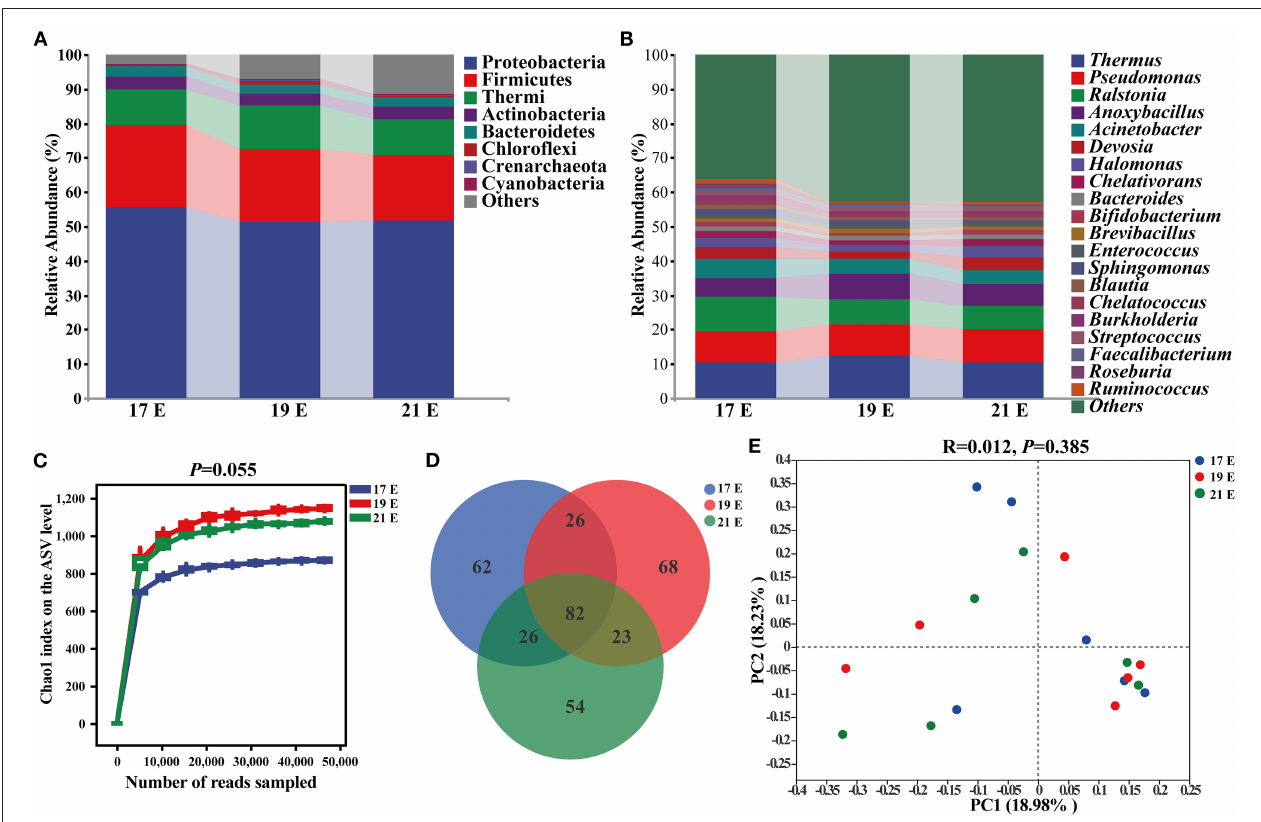
FIGURE 3 | Composition and diversity analysis of intestinal microbiota from control chick embryos at the age of embryos 17–21. (A,B) At phylum and genus level, respectively; (C) Chao1 index on the ASVs level; (D) A Venn diagram based on genus level; (E) Principal coordinate analysis (PCoA) based on weighted unifrac distance; 17, 19, and 21 E, at the age of embryos 17, 19 and